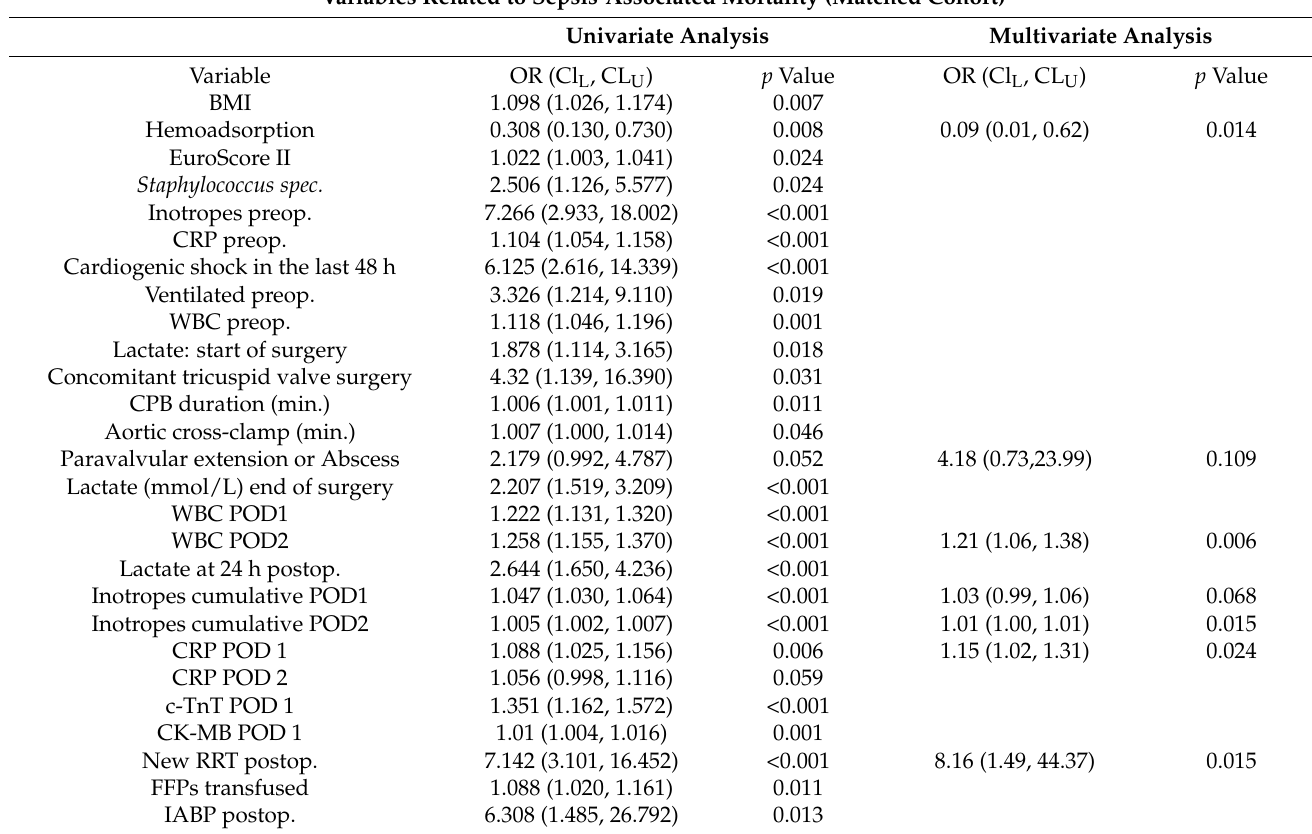
Table 5. Variables related to sepsis-associated mortality.